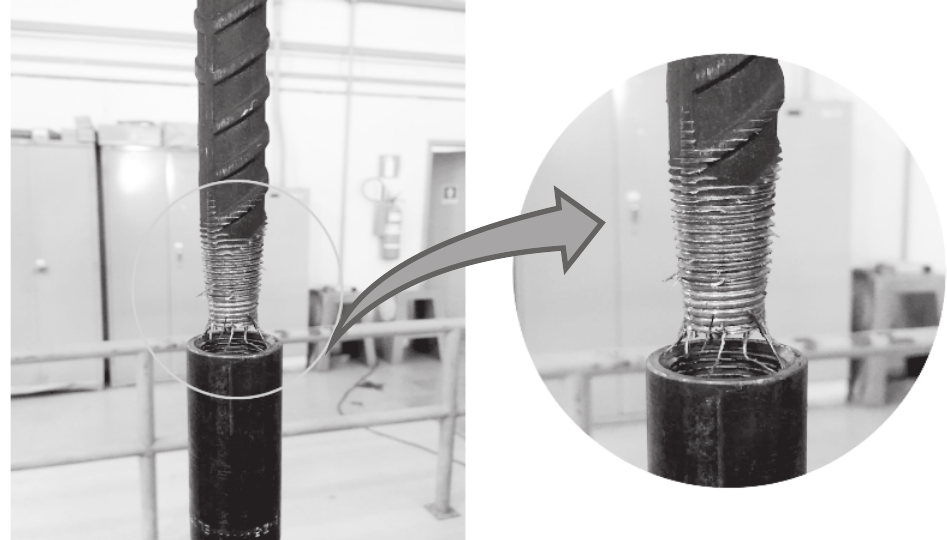
Detailed view post-rupture of spliced bar with taper-threaded coupler